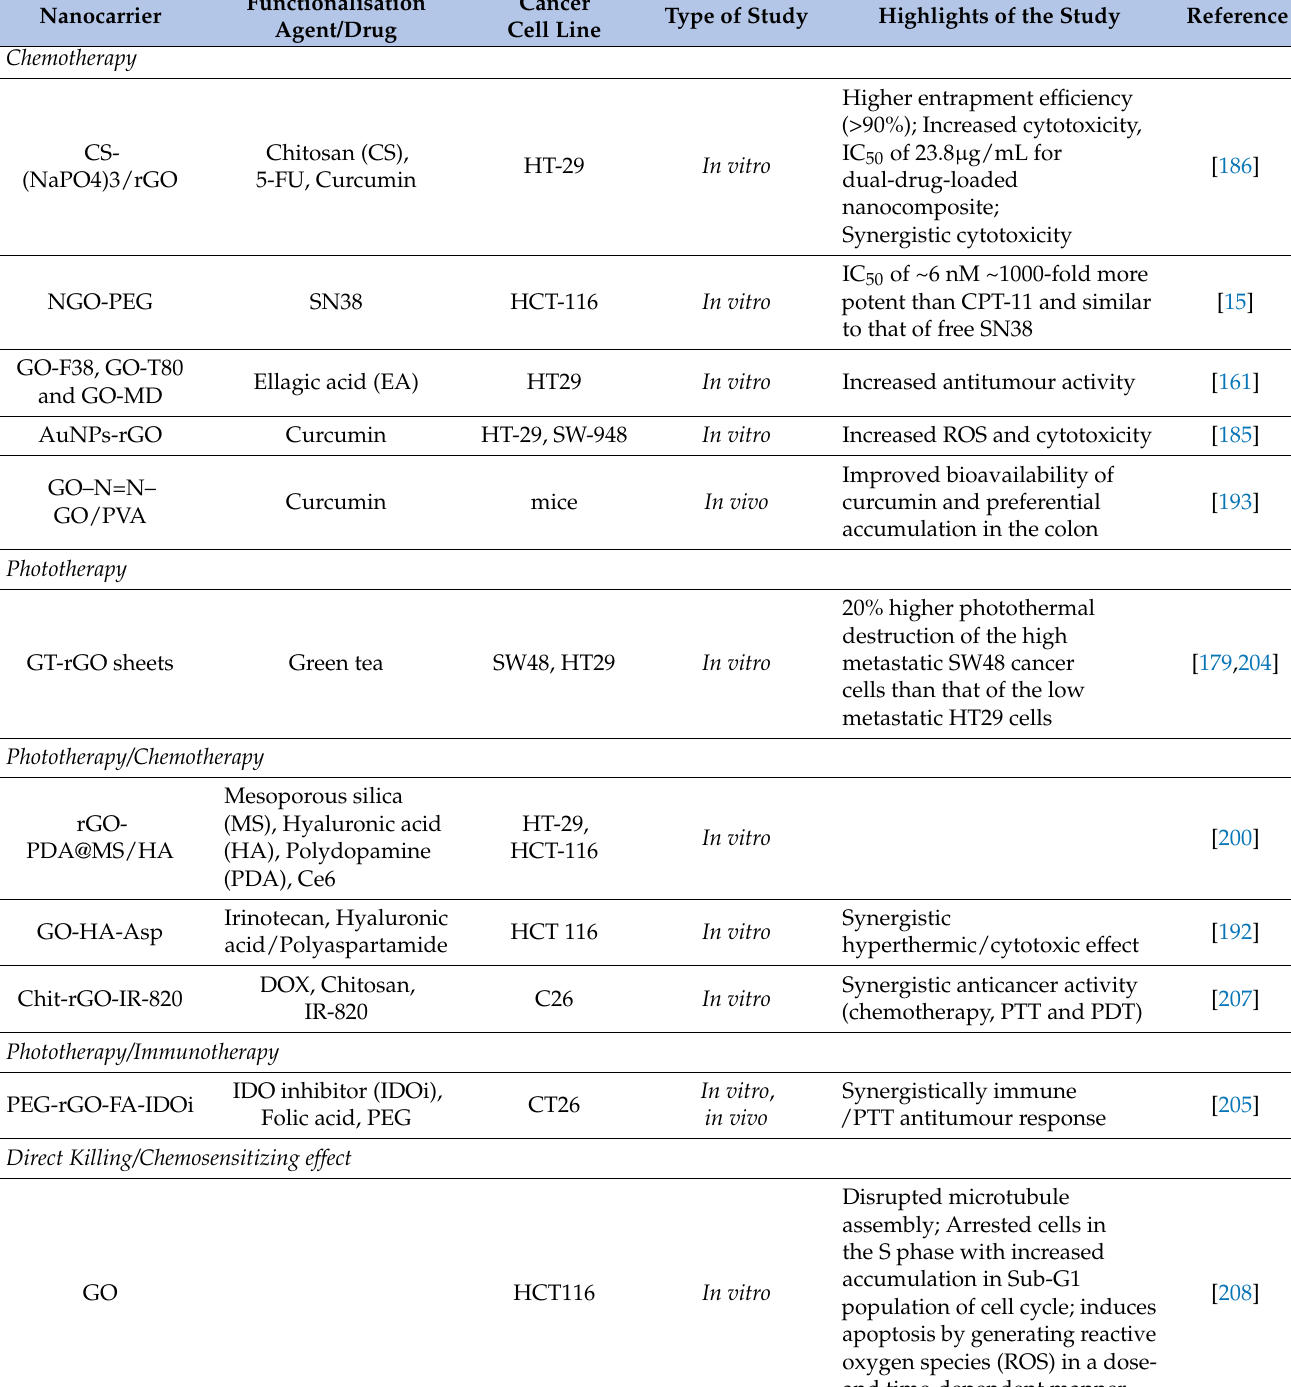
Table 4. Grapheneoxide-based nanoformulation for application in colorectal cancer